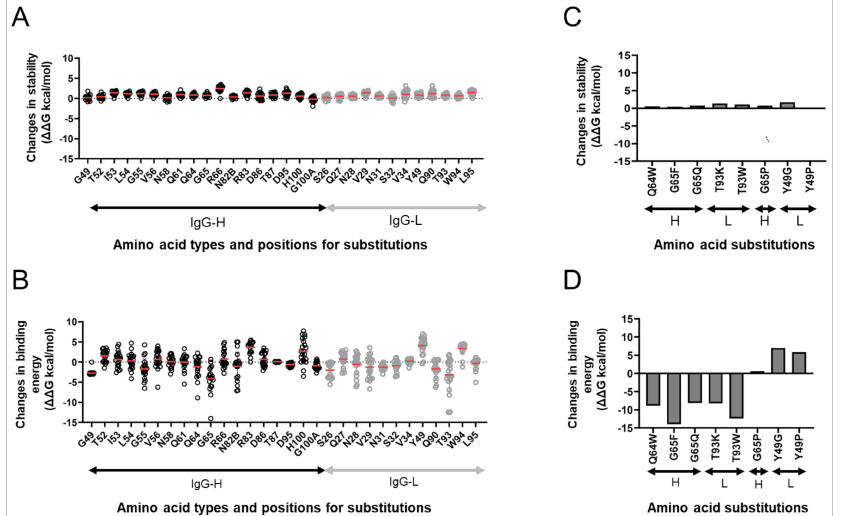
Figure 5. In silico site-directed mutagenesis. F11 Fab residues capable of noncovalently interacting with HA (Figure 3A) and the surrounding residues were individually exchanged for 19 nonself residues, and changes in the stability and binding affinity of F11 Fab were calculated using the F11/HA complex structure obtained at 200 ns of MD simulations as described previously [44–46] using the Protein Design application of MOE. ( A , C ) Effects on the stability of the F11 Fab fragment. ( B , D ) Effects on the binding affinity of the F11 Fab fragment to the HA ectodomain. ( C , D ) Results on F11 mutants used for the experimental